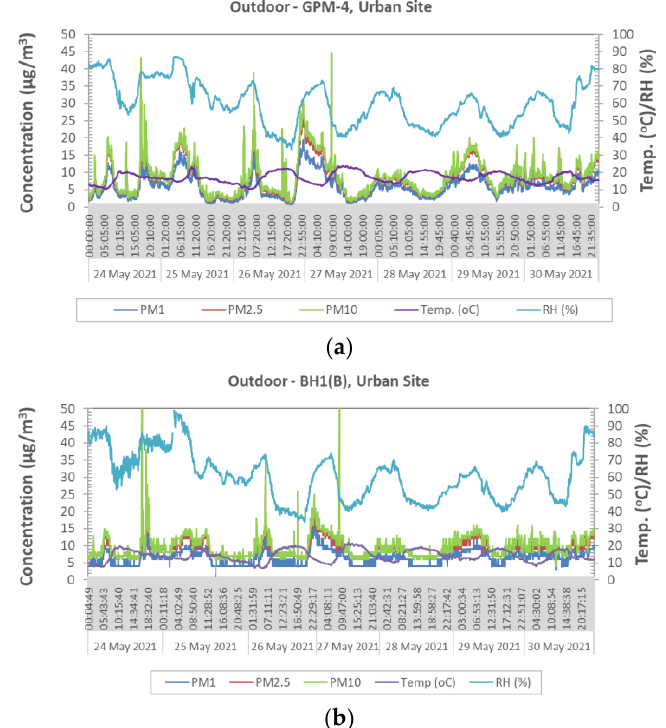
Figure 12. Temporal PM and microclimatic data series for ( a ) GPM and ( b ) BH1 monitors at the urban site, recorded between 24 and 30 May, 2021 (sampling rate: 1 – 5 min, n = 2300).